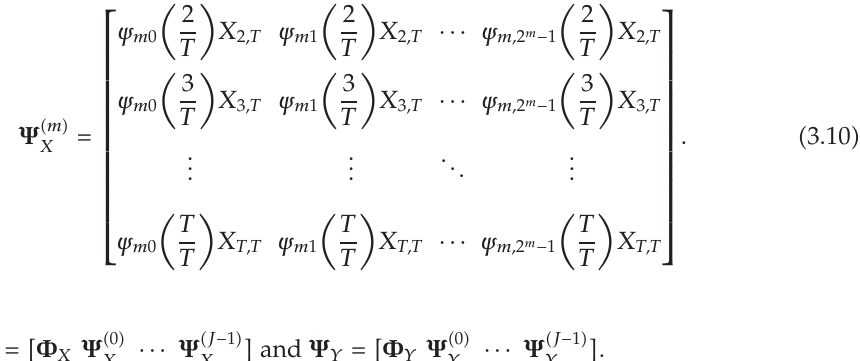
(cid:5) m (cid:6) X are given, for 0